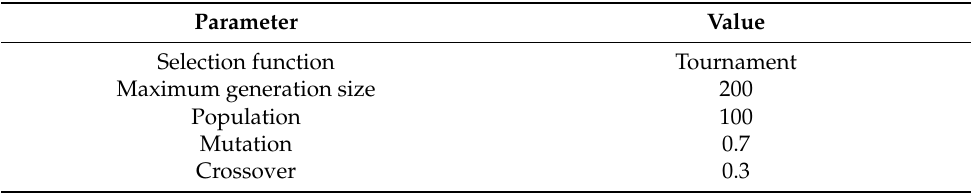
Table 9. Parameters of the optimization process.